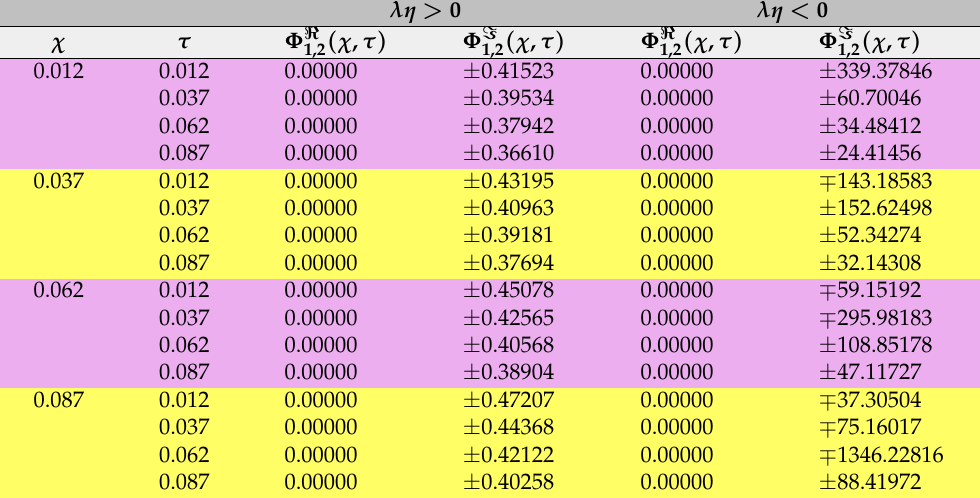
Table 1. The imaginary and real parts of the analytical solutions of Equation (4) are obtained by the G (cid:48) expansion method, with diverse point sources, though arbitrary, and α = 0.90. G 2 −